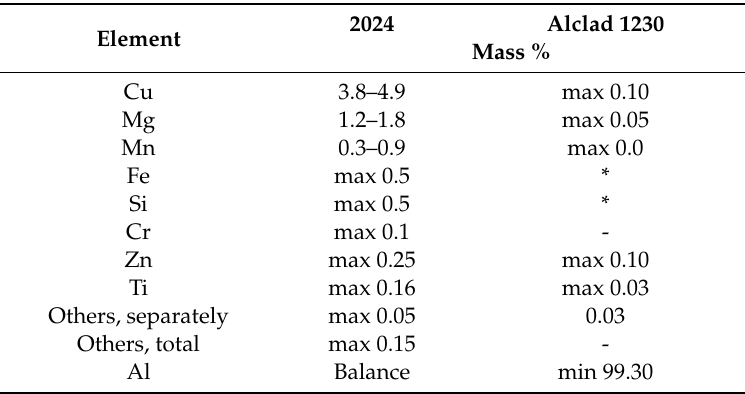
Table 1. Chemical composition of 2024 alloy and alclad 1230.